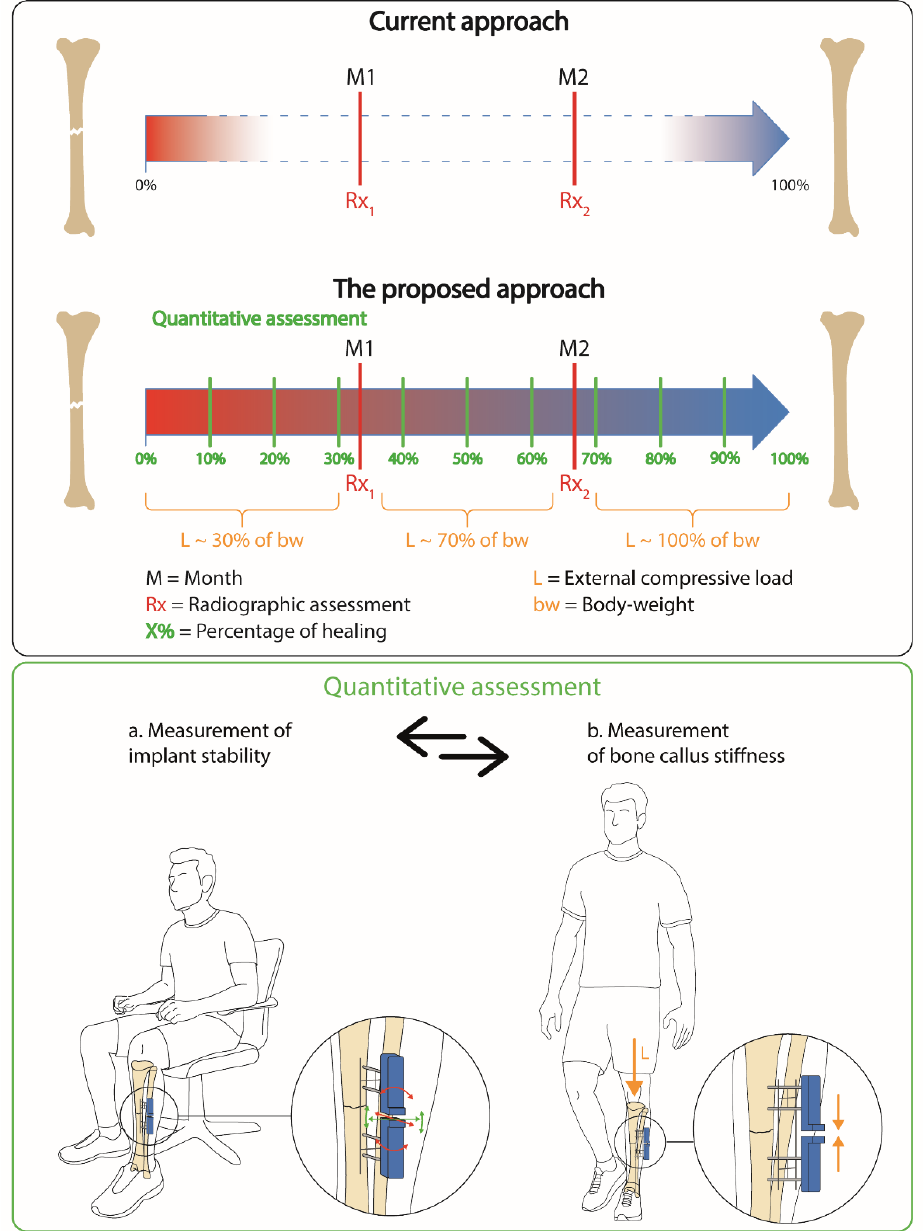
Figure 1. Management of bone fracture assessment: current approach versus our proposal .